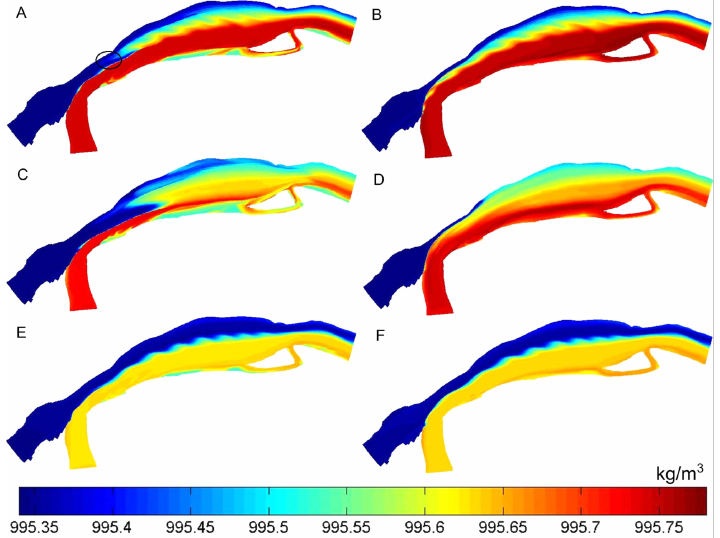
Figure 11. The density profiles in the Rio Negro–Solimões model runs. ( A ) Highest momentum ratio, top layer. ( B ) Highest momentum ratio, bottom layer. ( C ) Low flow, top layer. ( D ) Low flow, bottom layer. ( E ) High flow, top layer. ( F ) High flow, bottom